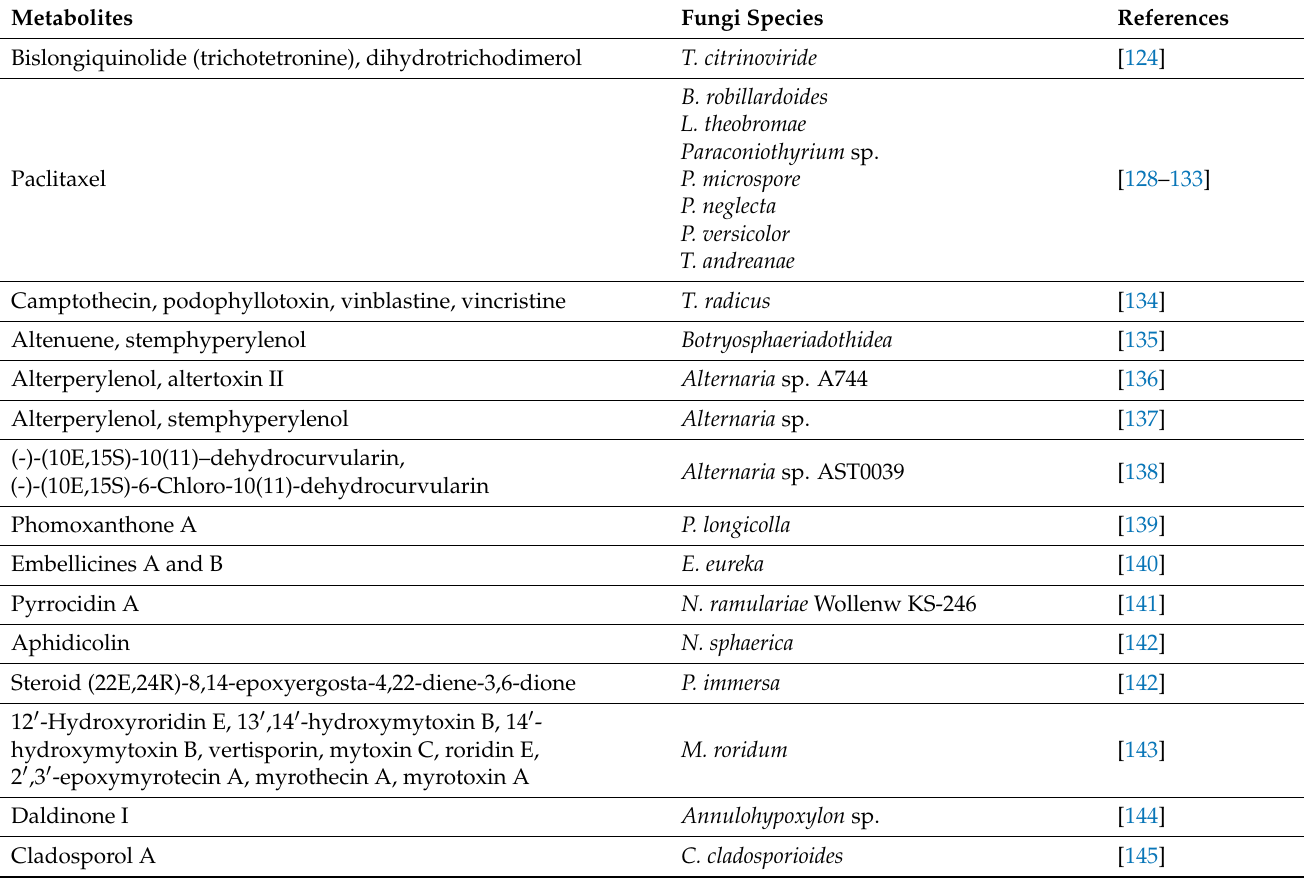
Table 1. Examples of cytotoxic secondary metabolites produced by fungi species.